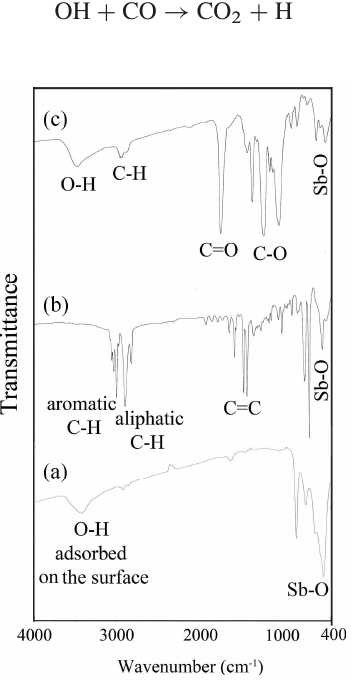
Figure 10. TGA curves of (a) pure PMMA, (b) PMMA/Sb 2 O 3 -Br